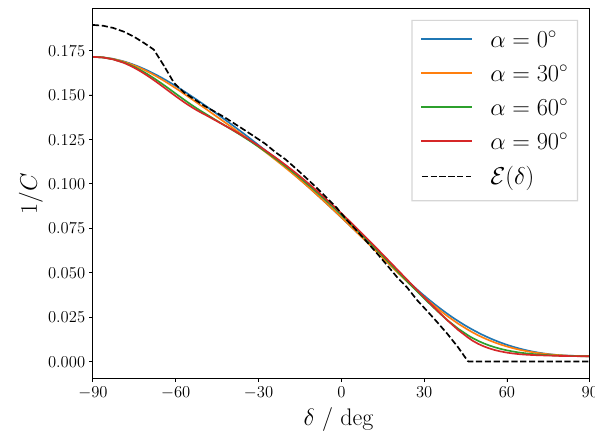
Fig. 4 Integral 1 / C of exposure-folded Gaussian probability distribu- tion as a function of the equatorial declination δ for the center direction of the ellipse. The semi-major and semi-minor axis are δ max = 30 ◦ and δ = 10 ◦ , respectively. Colored lines denote different ellipse orienta- min tions α . The black dashed line indicates the probability density function value of the normalized exposure E